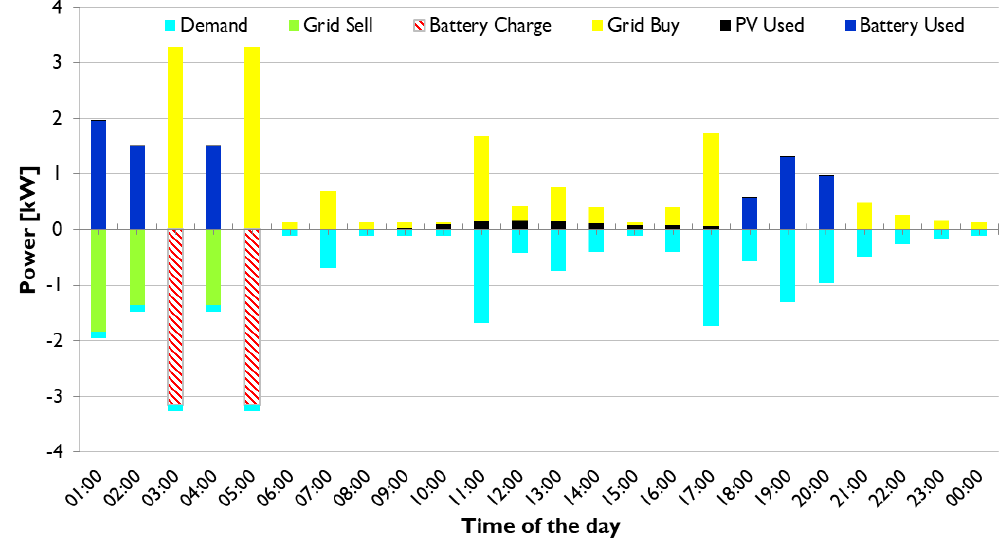
Figure 9. Power balance of the proposed hybrid system for a sample winter case.